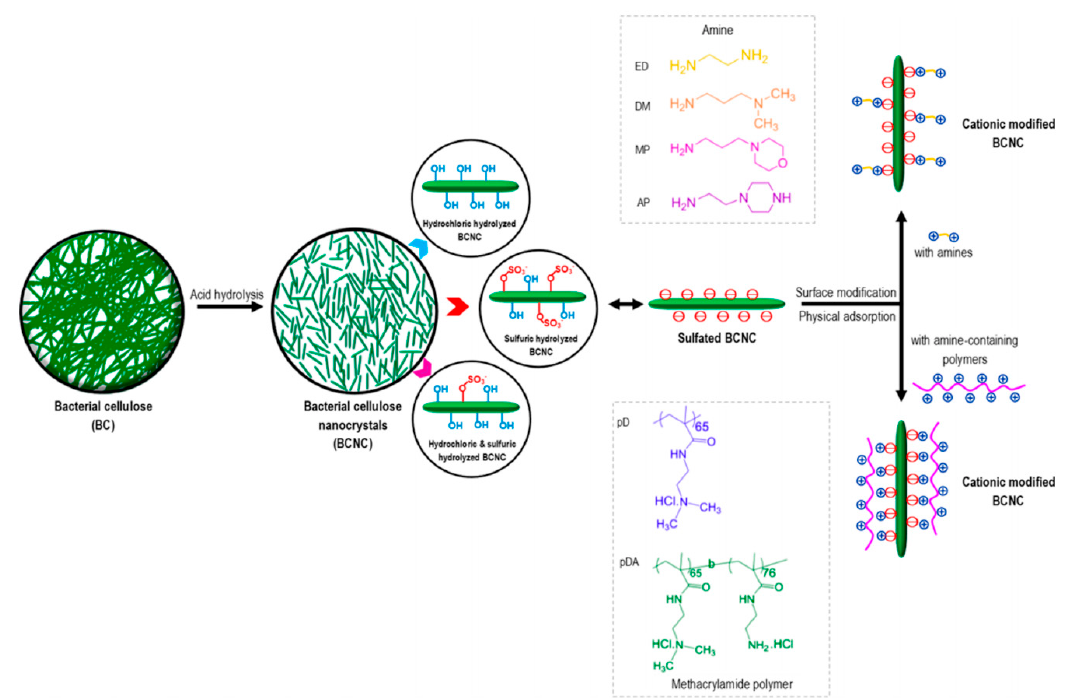
Figure 8. Schematic diagram of BCNCs Production from BC by acid hydrolysis with different types of acid and cationic surface modification of sulfated BCNC by physical adsorption techniques with amines and amine-containing polymers (methacrylamide polymers). Reprinted with permission from Ref. [66]. Copyright 2018 American Chemical Society.